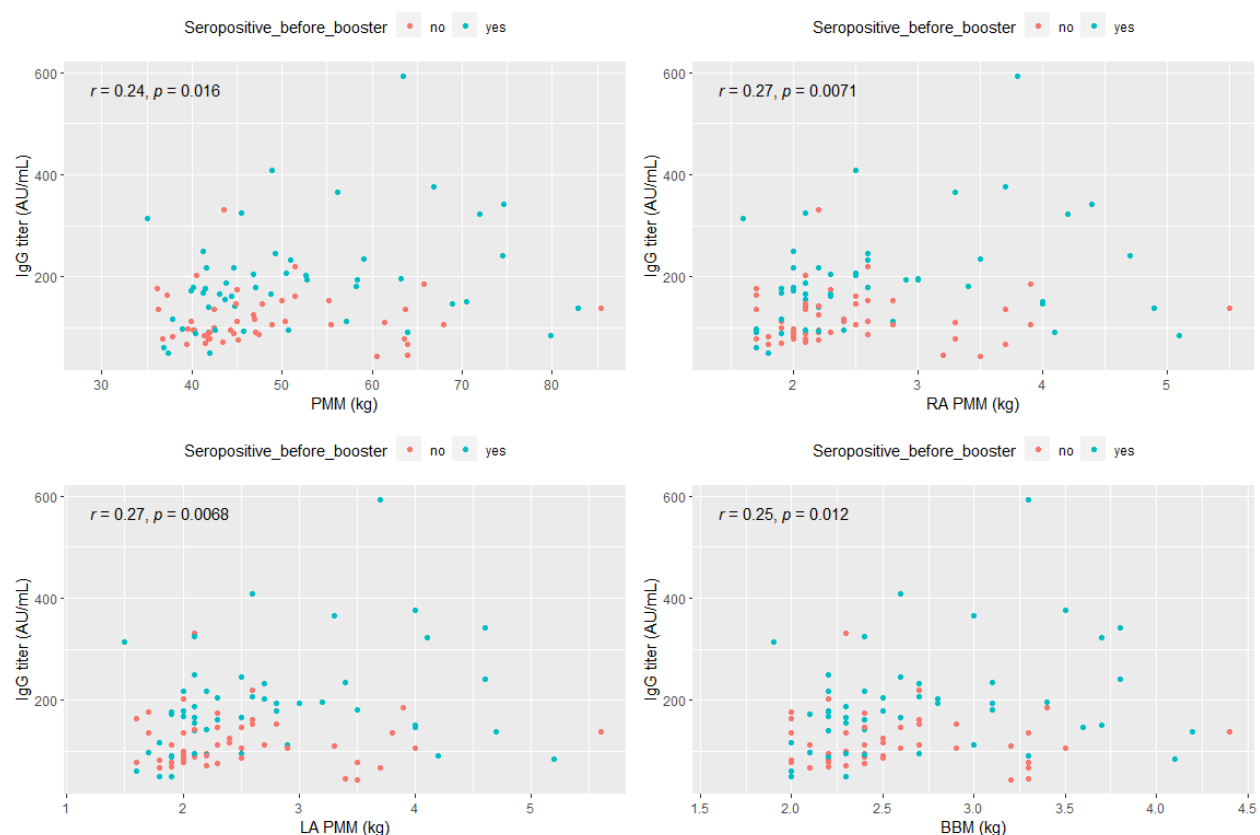
Figure 4. Spearman correlation between anti-SARS-CoV-2 IgG titer and selected parameters associ- ated with the musculoskeletal system. Abbreviations: PMM—predicted muscle mass, RA PMM— right arm predicted muscle mass, LA PMM—left arm predicted muscle mass, BBM—body bone mass.